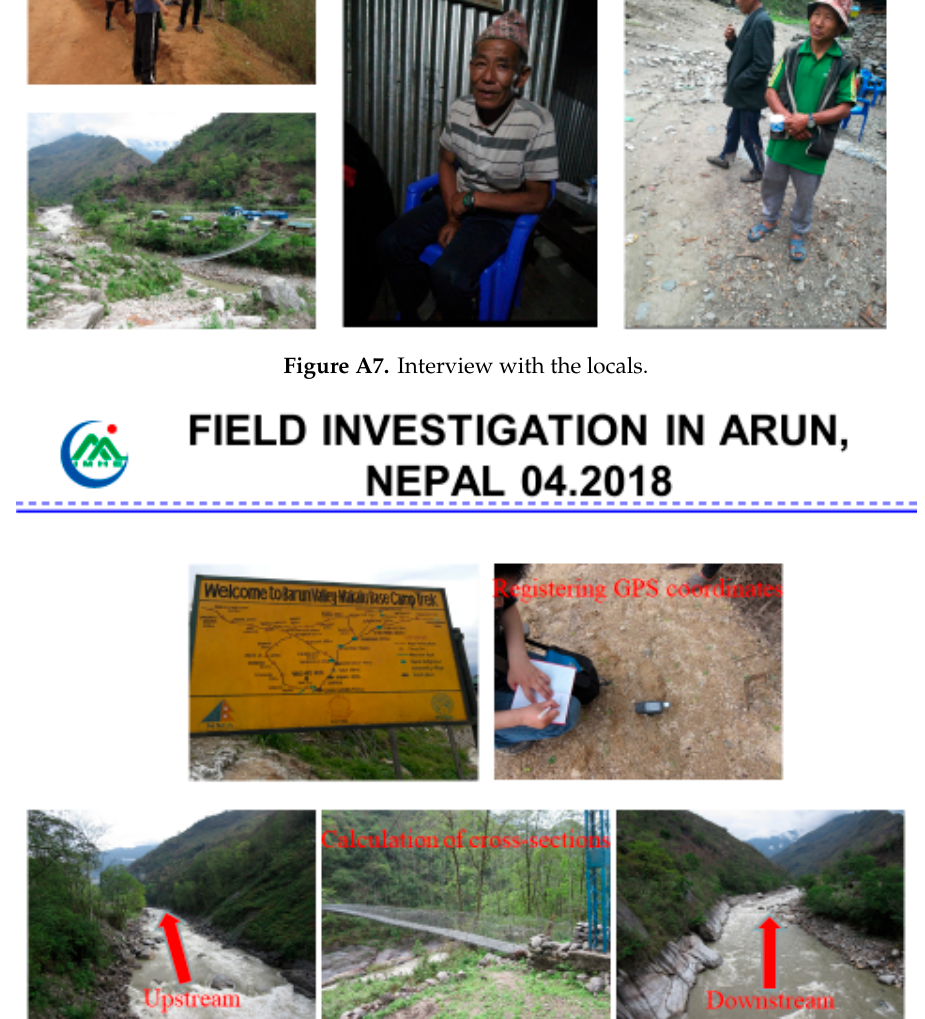
Figure A8. Field activities at the lower dam site.